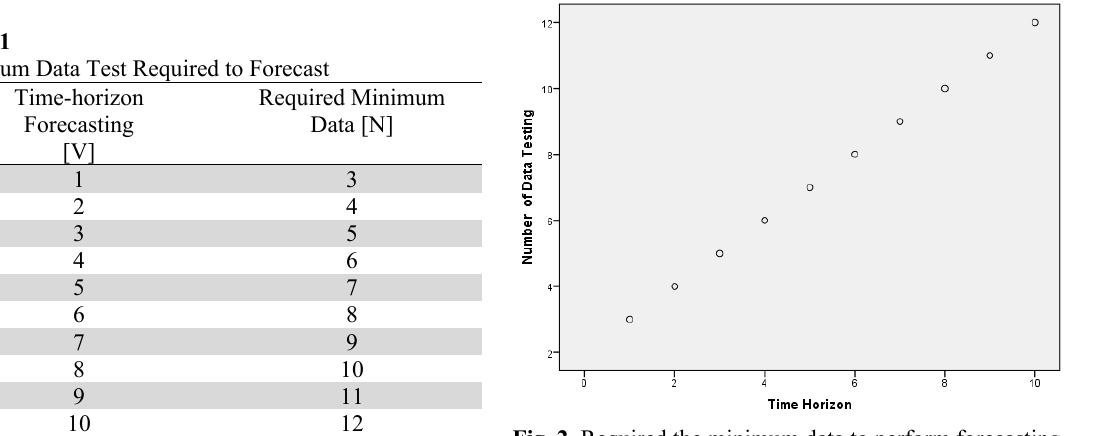
Fig. 2. Required the minimum data to perform forecasting